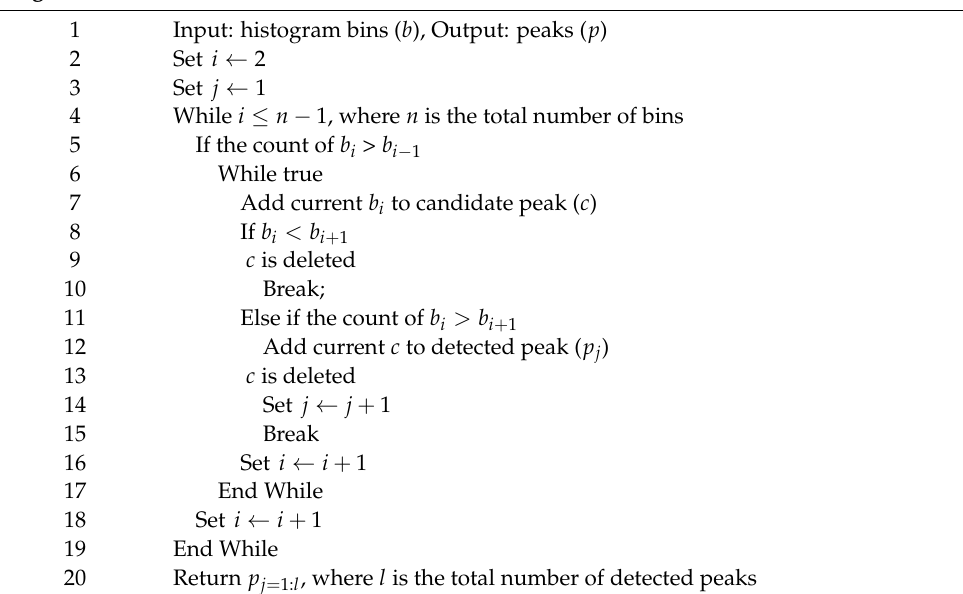
Algorithm 1. Peak Detection Method